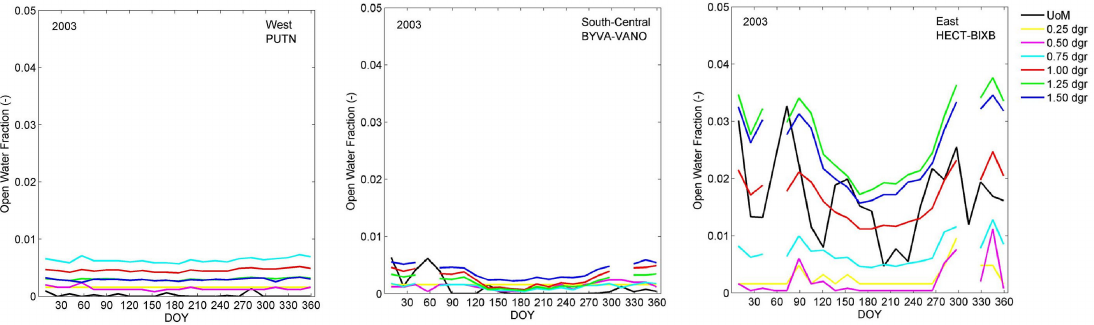
Fig. 4. Time series of the MODIS-derived Open Water Fraction for the 0.25 ◦ grids cells in the Western, South-Central and Eastern Oklahoma area for increasing grid cell sizes, together with the UoM open water fraction.